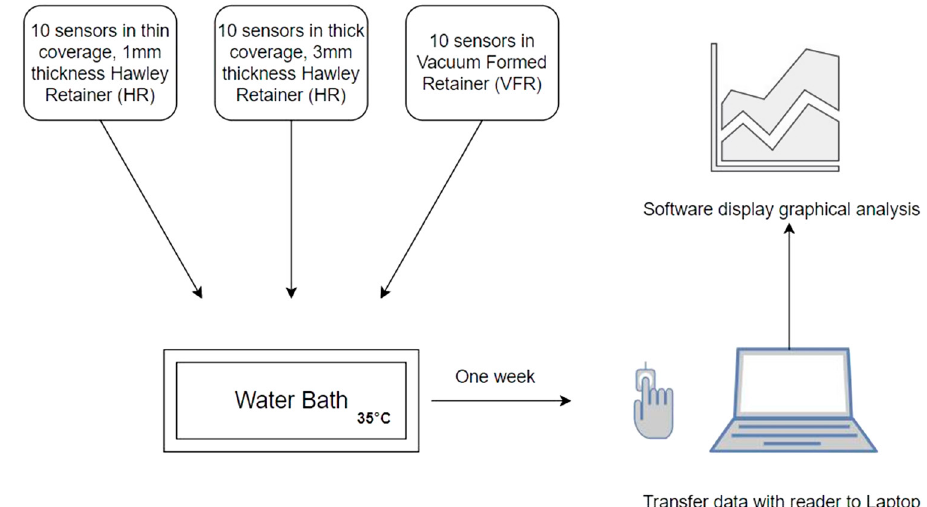
Figure 2. Characteristics of included groups and flowchart of